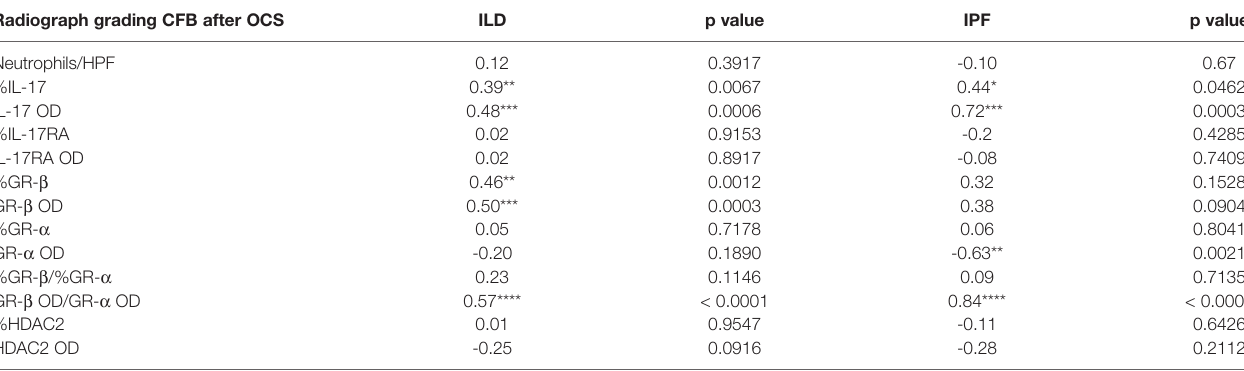
TABLE 3 | Correlations between radiographic deterioration and staining fi ndings (neutrophil counts, IL-17, GR- b , GR- a , GR- b /GR- a , HDAC2) in ILDs (COP, sarcoidosis and IPF in combination) and IPF subgroup. Radiograph grading CFB after OCS ILD p